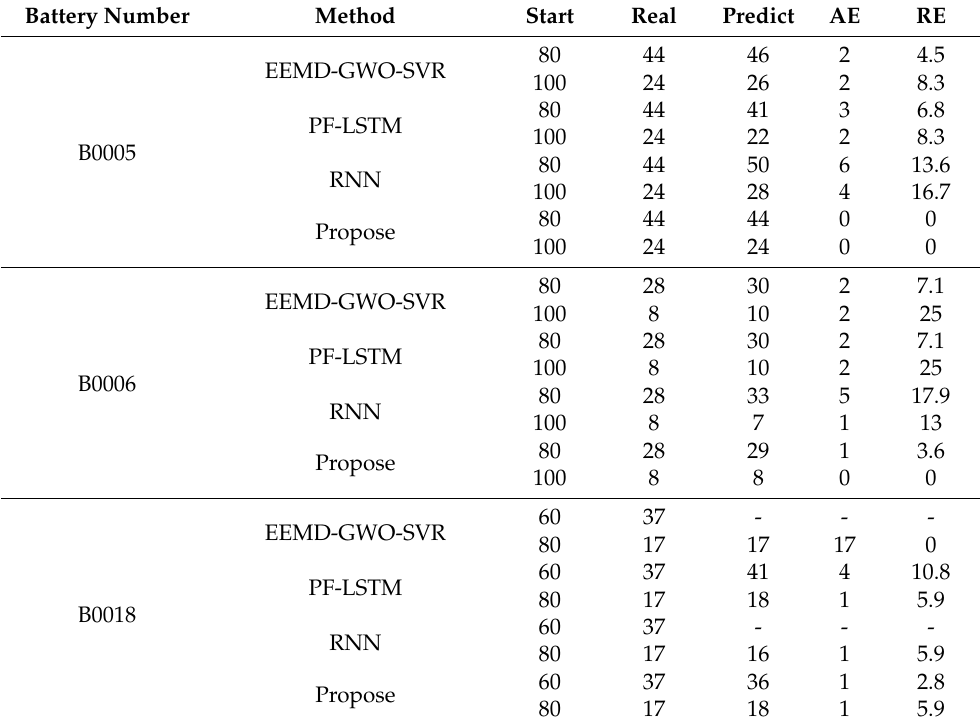
Table 6. Comparison between the algorithm in this paper and other RUL prediction algorithms. Battery